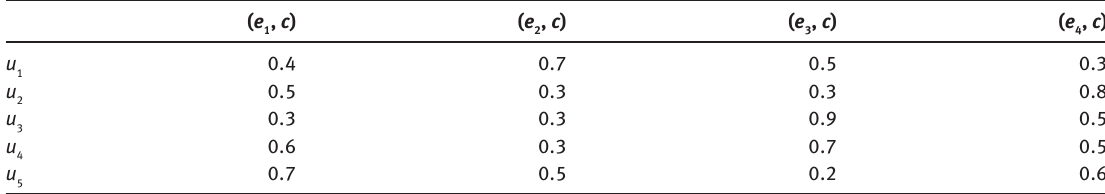
Table 3: Opinions of Expert c .